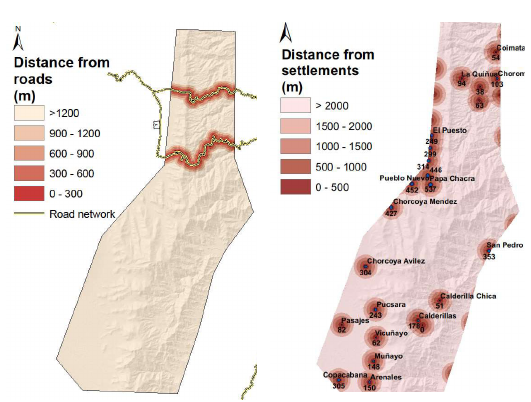
Figure 5. Weighted socioeconomic